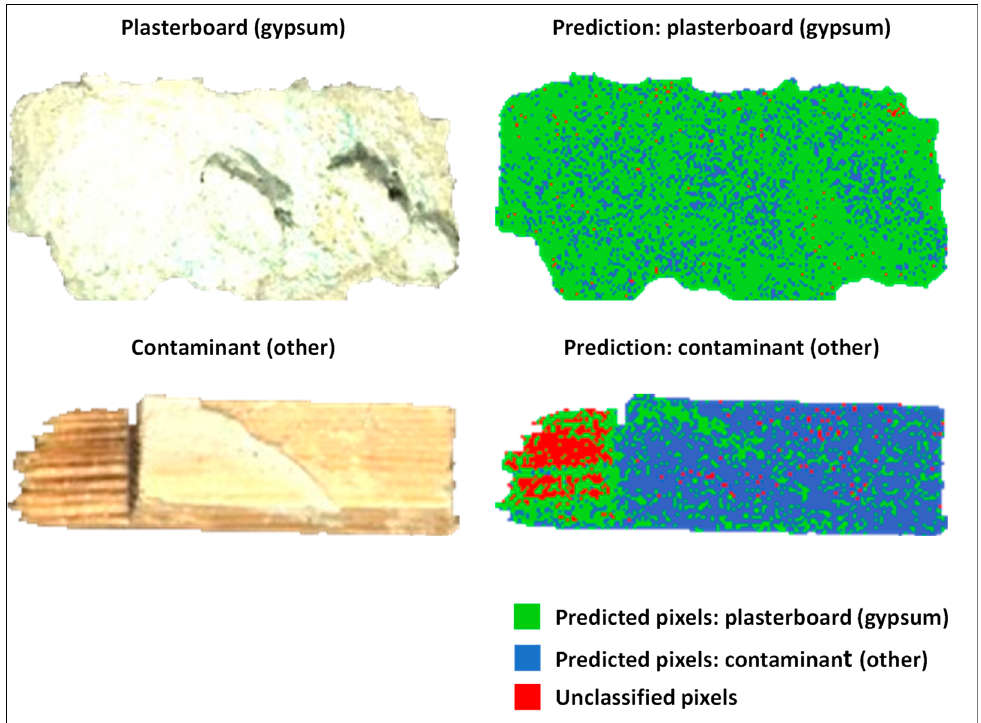
Figure 6. Pixel-based prediction maps obtained by applying the PLS-DA model to the refurbishment plasterboard waste in real-time classification laboratory tests (example images).